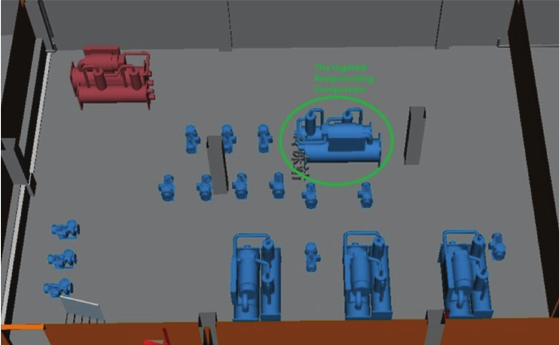
Figure 8: Targeted reciprocating compressor.